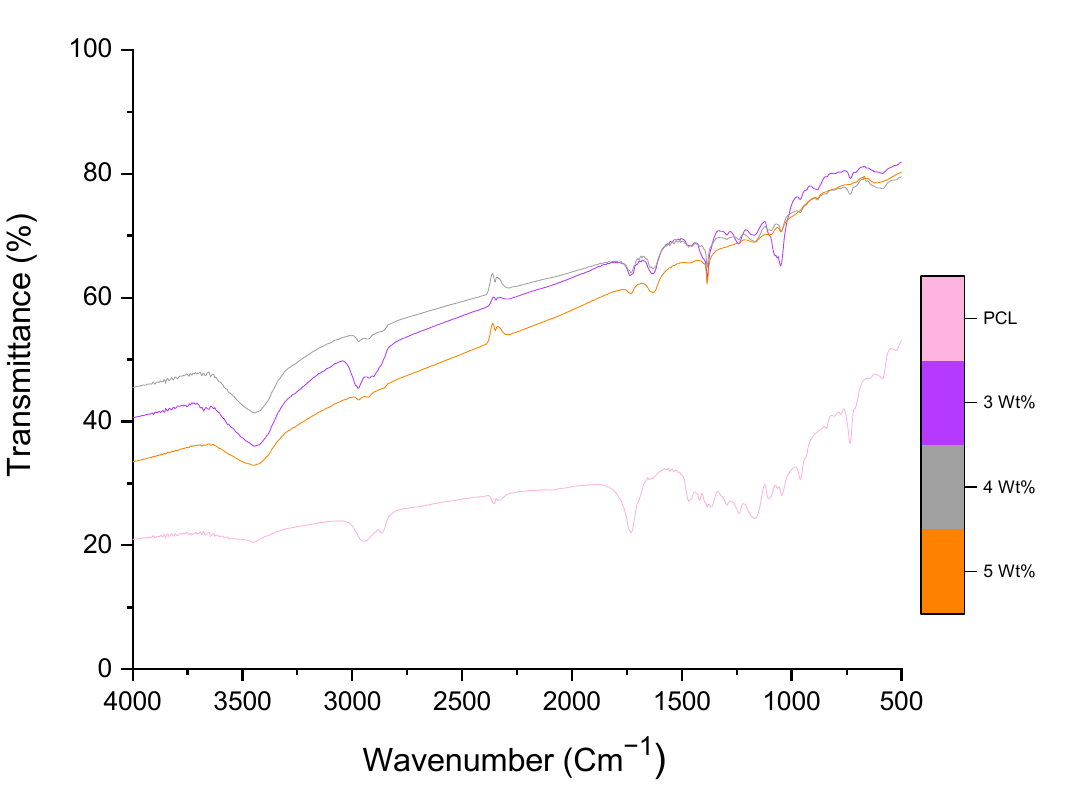
Figure 6. Fourier Transform Infrared (FTIR) spectra comparing the chemical compositions of pristine PCL fibres along with 3, 4 and 5 wt% PG-PCL fibres.